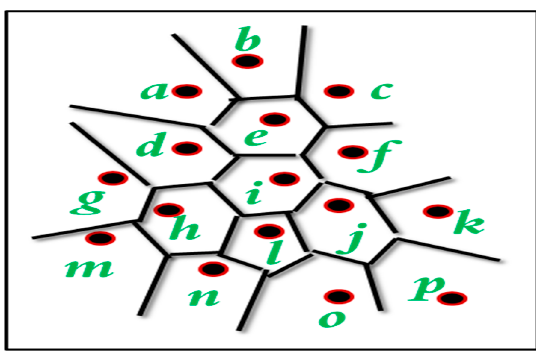
Figure 17. Pictorial overview of a wireless sensor network (WSN) in a graph form.